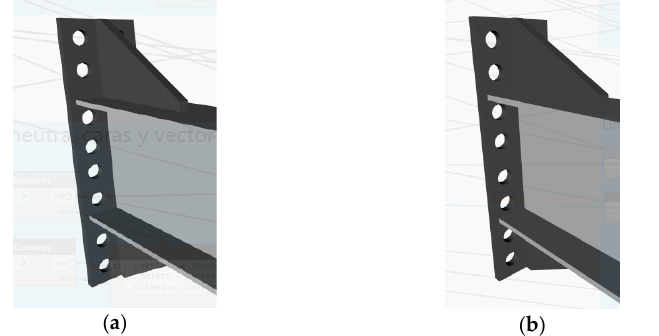
Figure 7. Geometry solutions for the end-plate connection: ( a ) geometry solution 1; ( b ) geometry solution 5. Source: the authors.